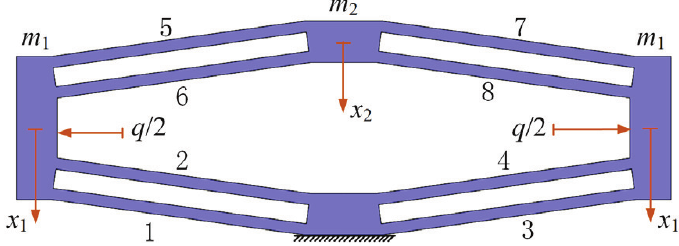
Figure 5. The generalized coordinates of the bridge-type